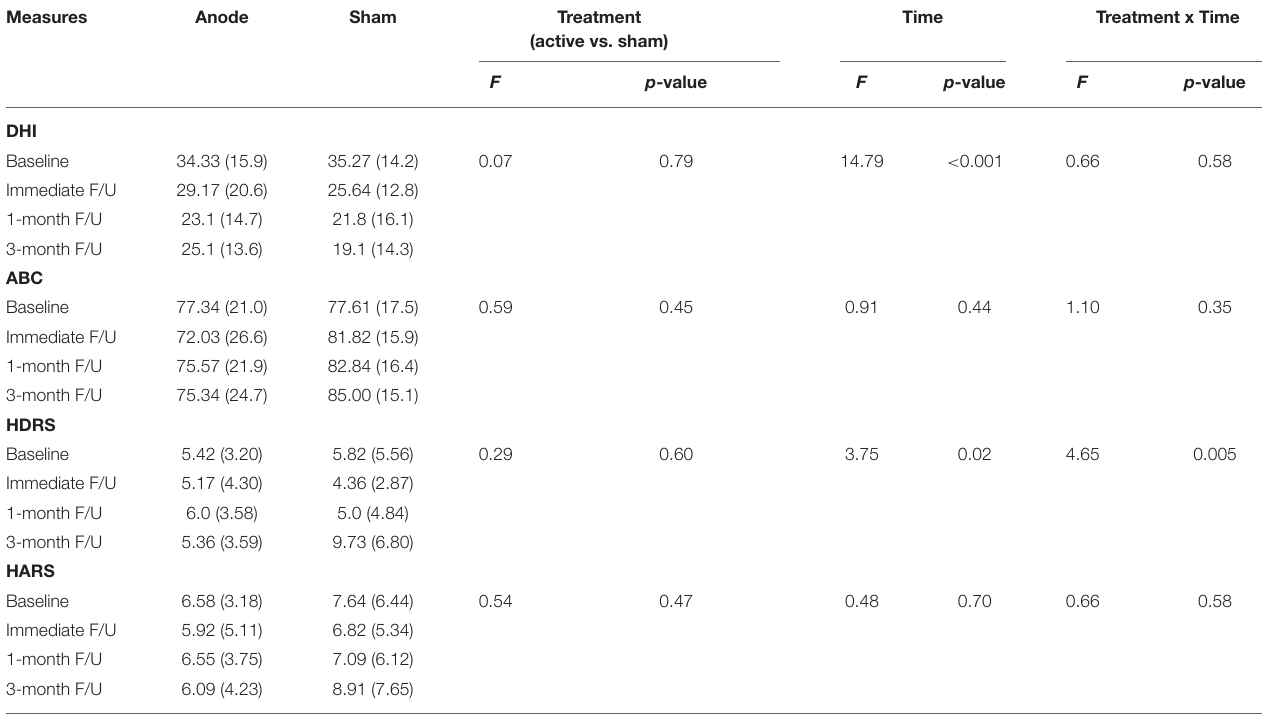
TABLE 2 | Summary of clinical variables across time and